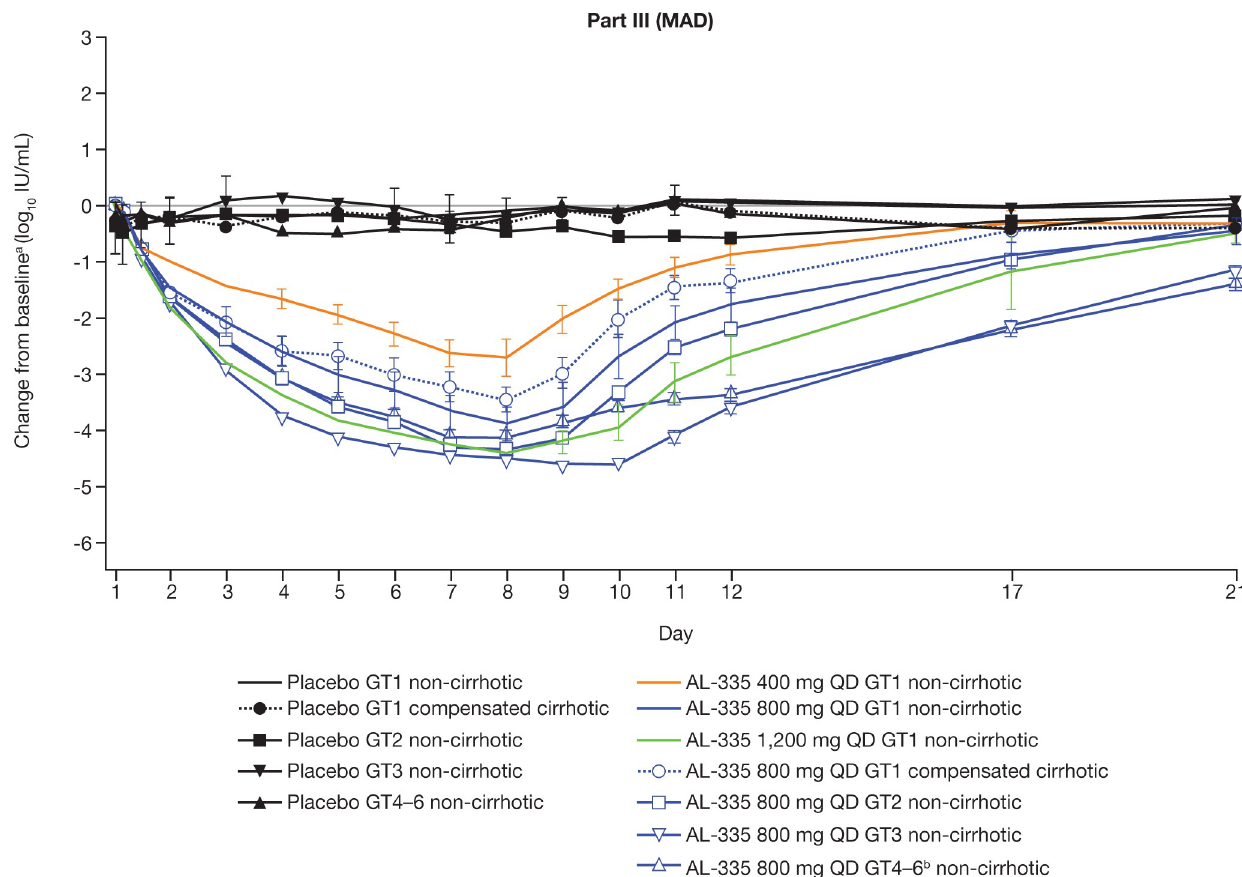
Fig 3. Mean ( ± SEM) HCV-RNA change from baseline (log 10 IU/mL) over time following multiple oral administrations of AL-335 (tablet form) under fed conditions (Part III, Days 1–7; pharmacodynamic set). Values below the LLOQ ( < 15 IU/mL) and with HCV-RNA detected have been replaced by the LLOQ value (= 15 IU/mL). Not detected values have been replaced by 10 IU/mL. a Baseline is defined as the average of Day -2 and Day 1 pre-dose values; b All randomized subjects in the GT4–6 cohort were infected with GT4. GT = genotype, HCV = hepatitis C virus, LLOQ = lower limit of quantification, MAD = multiple ascending doses, QD = once daily, RNA = ribonucleic acid, SEM = standard error of the mean.